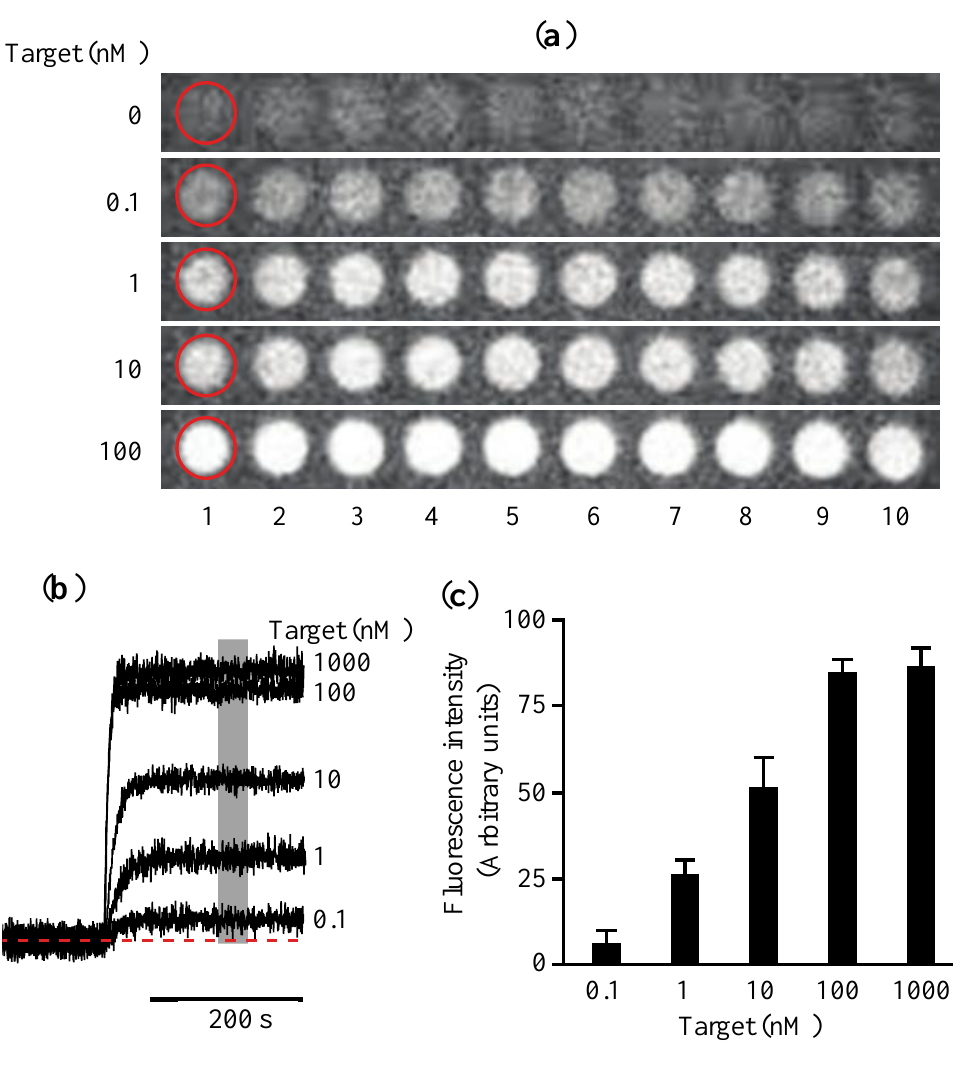
Figure 1. Sensitivity of the total internal reflection fluorescence (TIRF)-based microarray platform. ( a ) Examples of the signal detected by a charge-coupled device (CCD) camera arising from microarray spots developed to detect synthetic DNA sequences (for details please refer to the original publication [42]). To verify the reproducibility of the fluorescent signal the MB was spotted in tandems of 10 (left to right spots). Increasing concentrations of the target sequence were introduced in the system (from 0 used as control, 0.1, 1, 10 and 100 nM). The red circle indicates the region of interest (ROI) from which fluorescence was measured over time; ( b ) Mean fluorescence values obtained from the ROIs on the 10 fluorescent spots in the microarray illustrated in (a). The plots illustrate the time courses of association of the sample to the molecular beacons (MB). Dotted red line shows the background level. Each of the concentrations of the target tested is indicated at the right of the panel; and ( c ) fluorescence intensity (in arbitrary units, AU) illustrating the mean ± standard deviation obtained from the 10 fluorescent spots in the microarray shown in (a). Values were measured at the time indicated by the gray rectangle in (b). Notice that the limit of detection was around 0.1 nM. Figure adapted from [42], with permission from the authors.